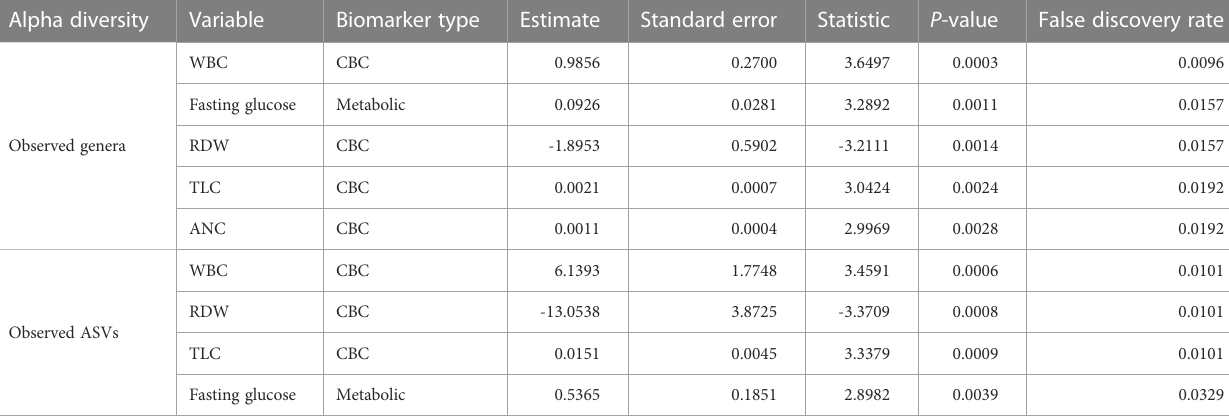
TABLE 1 Signi fi cant associations of the number of observed features (at the genus and ASV levels) with different